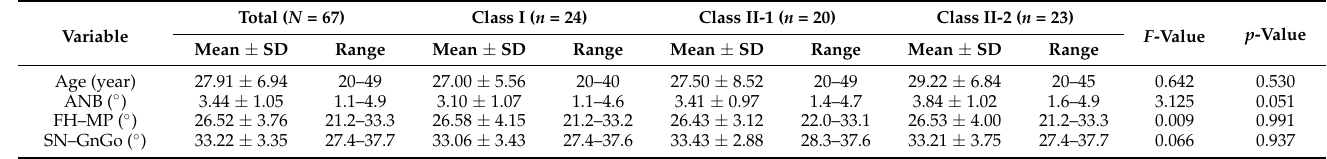
Table 1. Descriptive statistics of age and the basic measurements of the skeletal patterns.